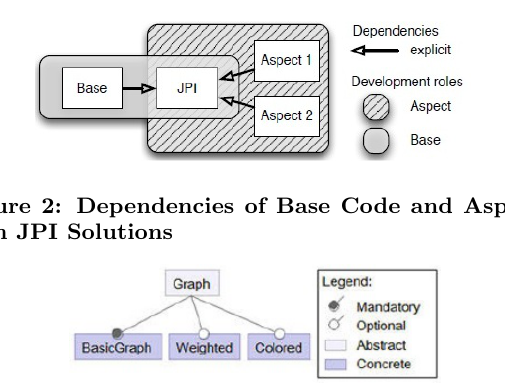
Figure 1: Implicit Dependencies of Advised Base Code and Aspects of Classic AOP Solutions